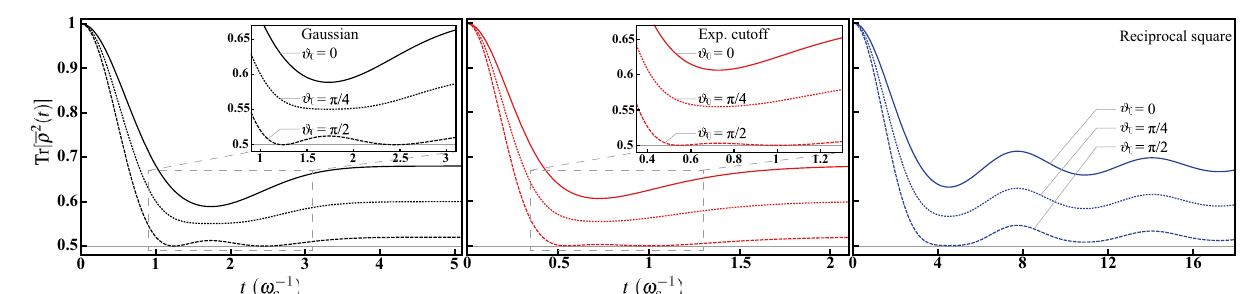
0 (solid curves), π/ 4 (dotted =